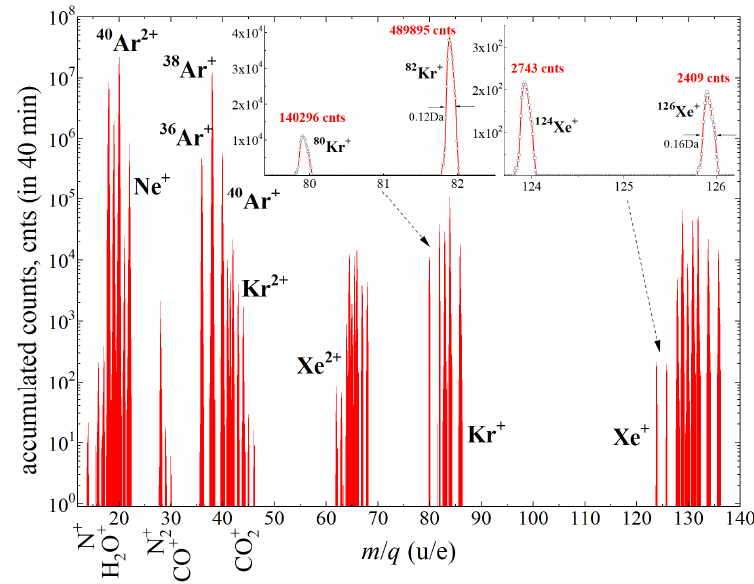
Figure 4. Synthetic mass spectrum of heavy noble gases at 10 mu bin resolution. The residual background species are listed in Table 5 and contribute to the low count background below 47 u. The mass bin width is demonstrated in both insets as open square symbols that are centered at the top of each bin, resulting in well‐defined line profiles.